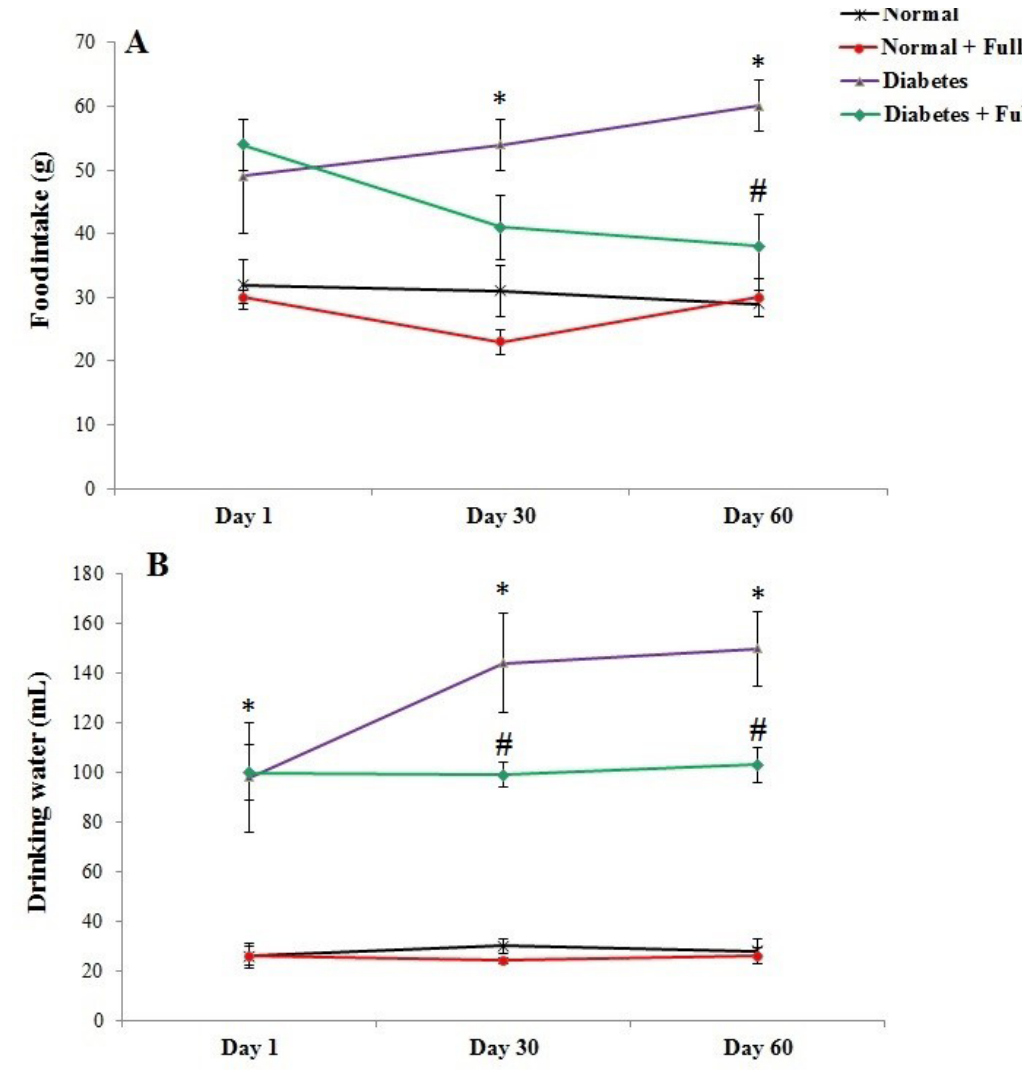
FIGURE 3 - Effects of fullerene on (A) food intake and (B) water intake on days 1, 30, and 60 after STZ injection. Differences in measured parameters among 4 groups analyzed by using One-way ANOVA, followed by the Tukey post hoc test. All the data were presented as mean ± standard deviation of the mean. The symbol * and # denote significant differences with the normal and diabetic groups, respectively; *P<0.05 and #